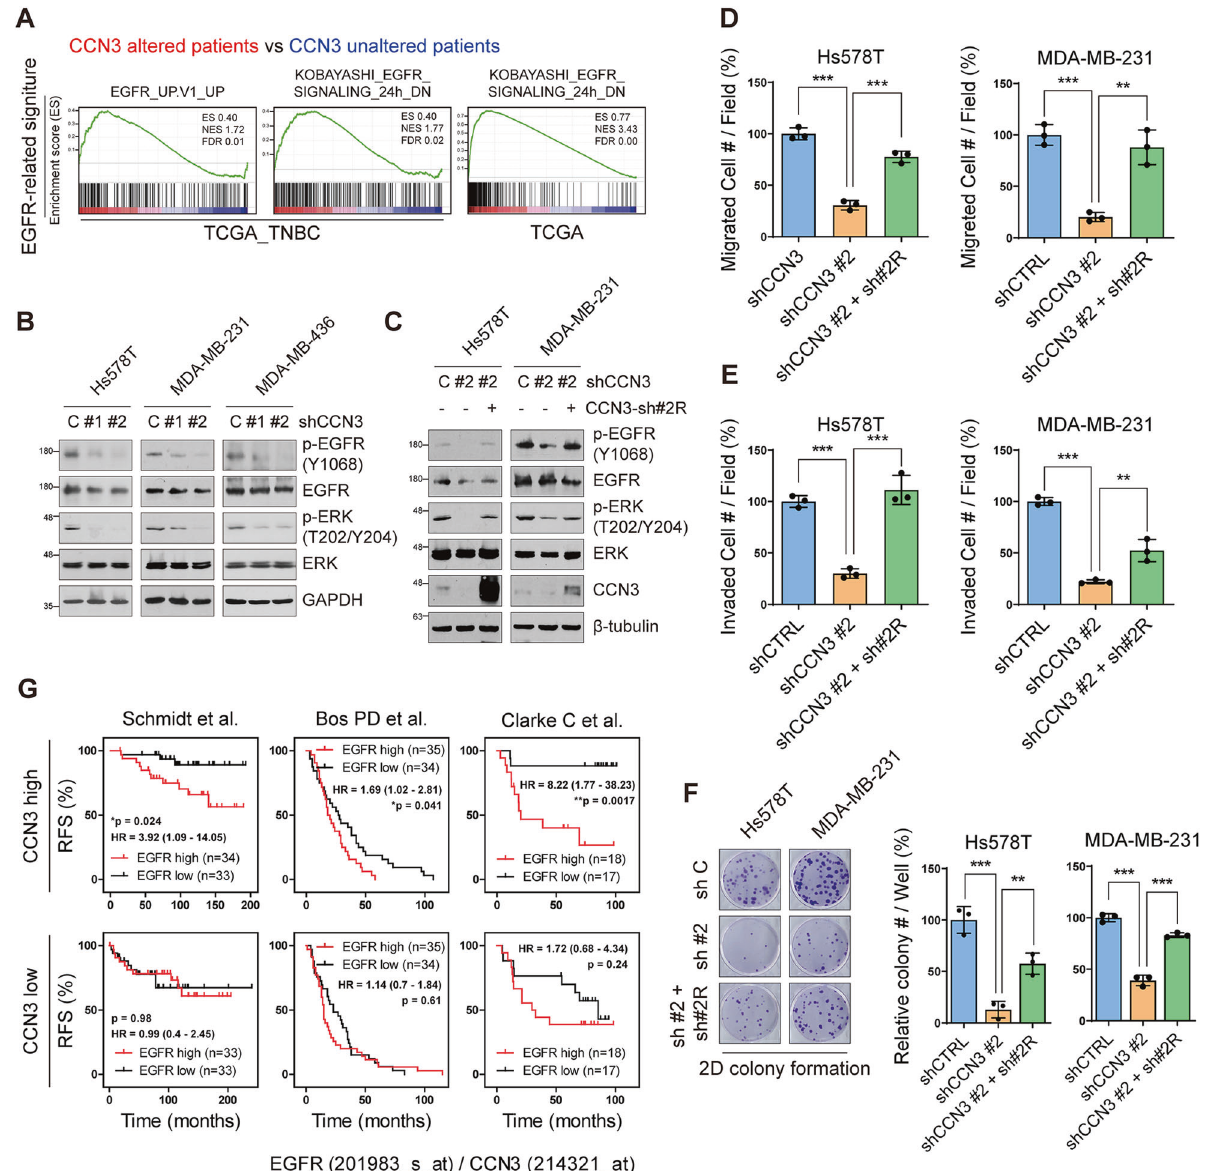
Fig. 5 CCN3 correlates with EGFR signaling in TNBC. A GSEA was performed with mRNA expression data from TNBC and all patients in TCGA (Cell, 2015). Plots indicate EGFR-related gene signatures were enriched in CCN3 altered patients. ES; enrichment score, NES; normalized enrichment score, FDR; false discovery rate. B Western blot analysis of whole cell lysate of CCN3 knockdown cell lines with indicated antibody. GAPDH was used as a loading control. C Western blot analysis of whole cell lysate with indicated antibody. CCN3 knockdown cell line restored their expression by transfection with shRNA-resistant CCN3 construct. β -tubulin was used as a loading control. D – E Transwell migration ( D ) and invasion ( E ) assays were assessed with Hs578Ta and MDA-MB-231 CCN3 knockdown cell lines with or without shRNA resistant CCN3. Each value was normalized based on the value of the control cell line. Mean ± SD ( n = 3). P -values were calculated with a one-way ANOVA with a post-hoc Tukey multiple comparison test (** p < 0.005, *** p < 0.0005). F 2D colony formation assays were performed with Hs578T and MDA-MB- 231 CCN3 knockdown cell lines with or without shRNA resistant CCN3. Each value was normalized with the value of the control cell line. Mean ± SD ( n = 3). P -values were calculated with one-way ANOVA with a post-hoc Tukey multiple comparison test (** p < 0.005, *** p < 0.0005). G Recurrence-free survival (RFS) plot of patients with EGFR high versus low expression in each dataset. Upper panel indicated patients fi ltered above median expression of CCN3 and bottom panel indicated patients fi ltered below median expression of CCN3. P -values were calculated with log-rank